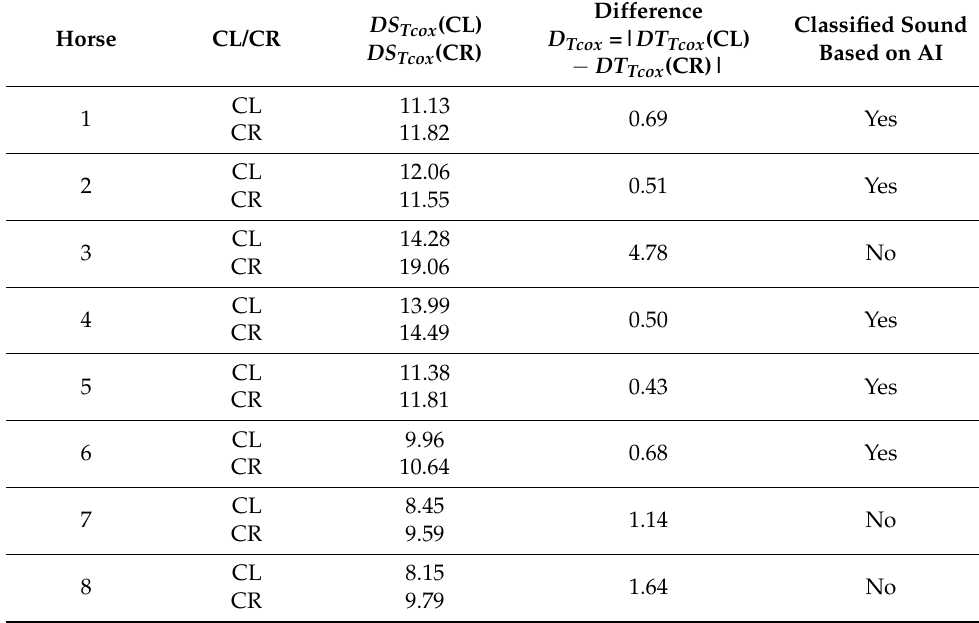
Table 4. Tuber coxae reference point—Non-lame